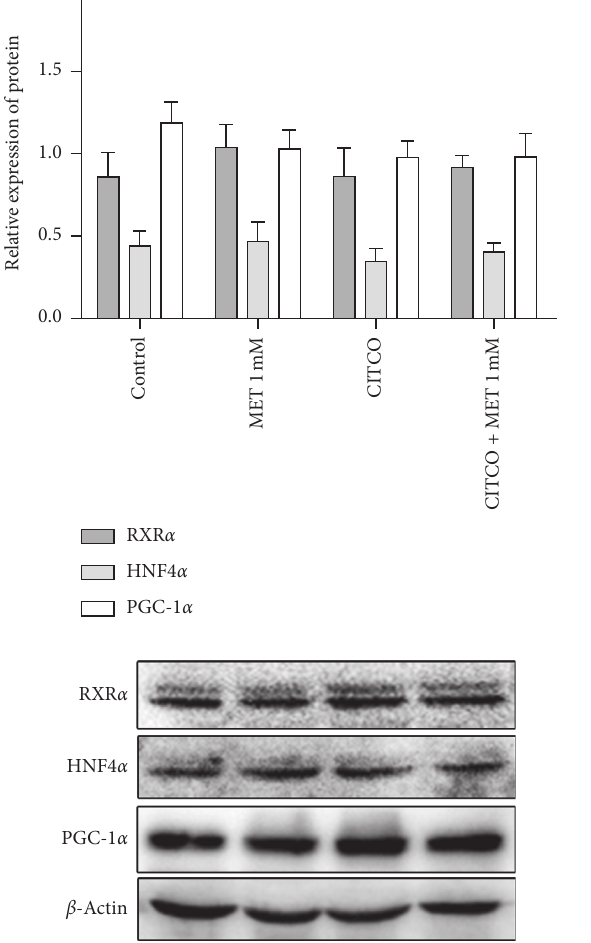
Figure 4: The effects of metformin on the levels of RXR α , HNF4 α , and PGC-1 α in HepaRG cells. HepaRG cells were treated with metformin (1 mM) and CITCO (1 μ M), either individually or in combination for 48h. Cells treated only with DMSO were con- sidered as the control group. Whole-cell extracts were harvested, and the expressions of RXR α , HNF4 α , PGC-1 α, and the internal control β -actin were analyzed using western blotting. Quantitation of the three protein bands was normalized to β -actin, respectively. A representative blot was shown and quantified by Image J soft- ware. The data shown are the mean ± SEM ( n �